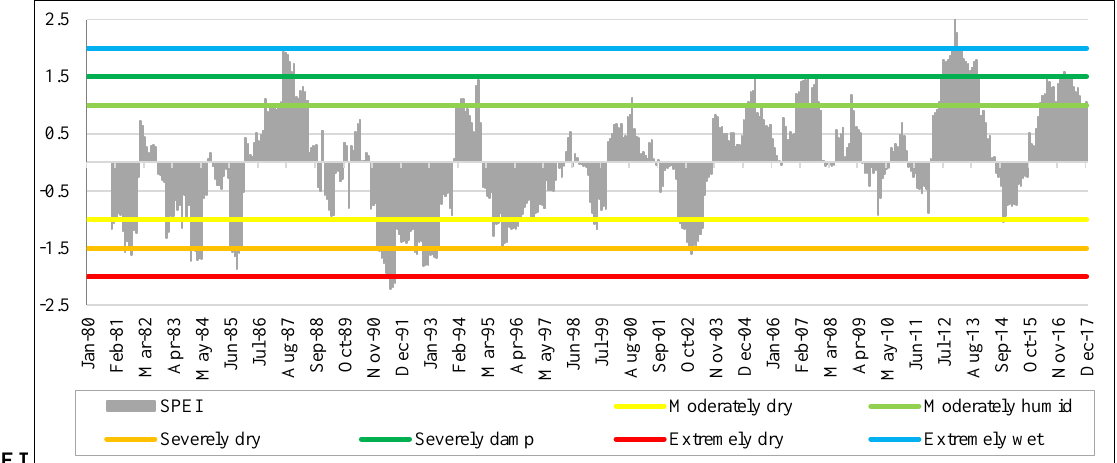
Figure 3. Average SPI (left) and SPEI (right) values for stations in the Casamance basin area (coloured lines indicate critical index values under dry and wet conditions)